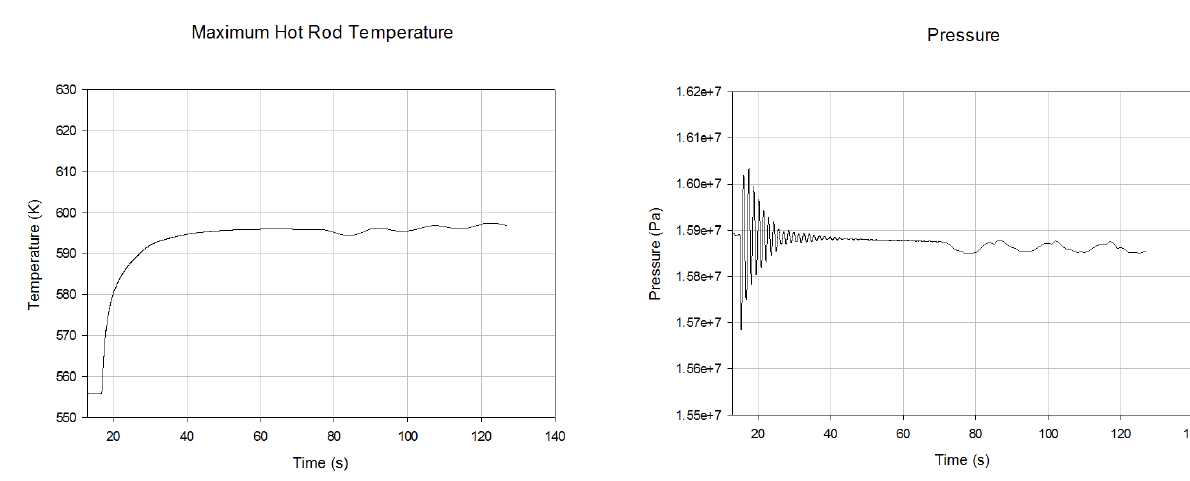
Figure 23. System